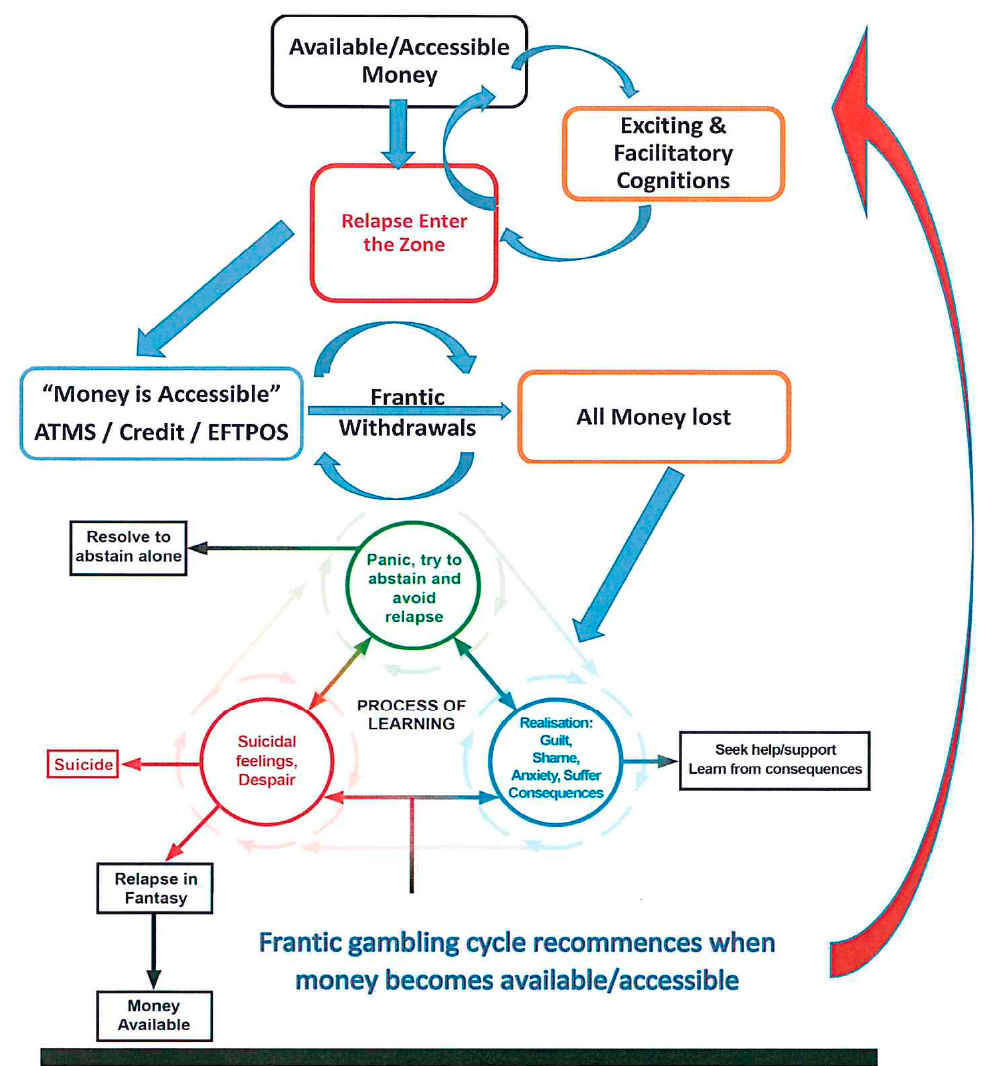
Figure 1. Financial Destruction and Problem Gamblers: A Model.